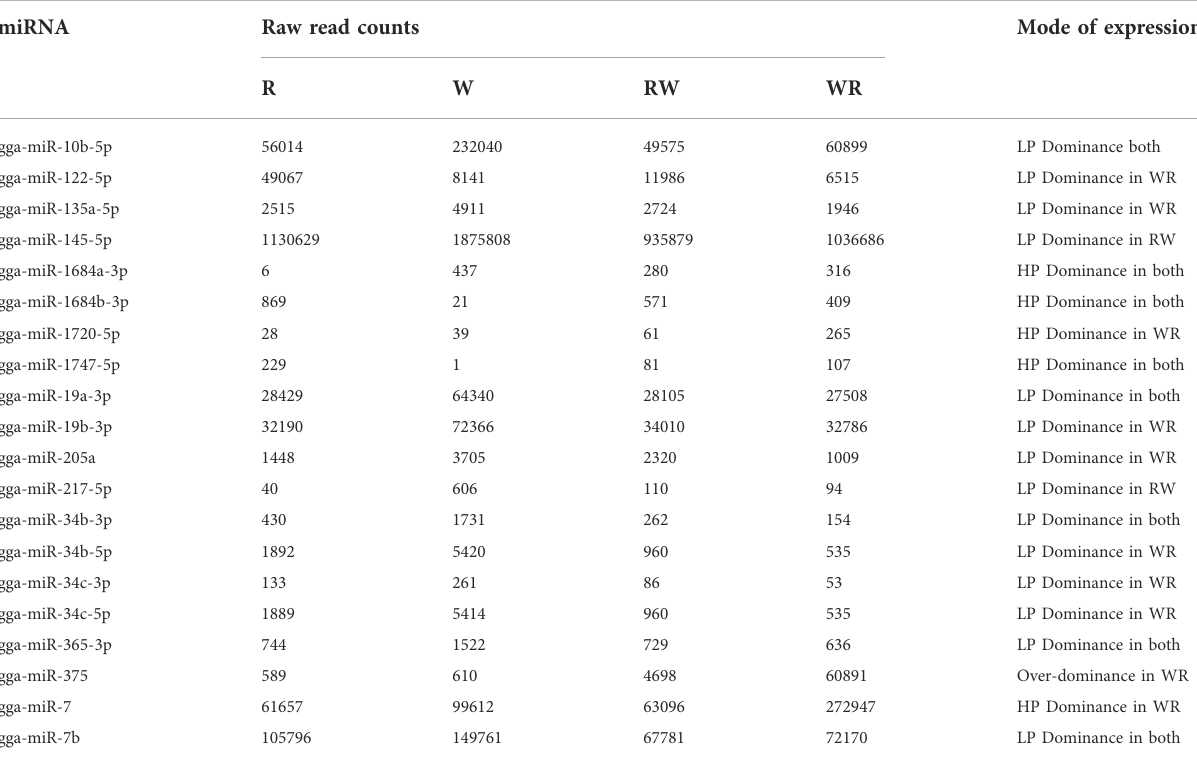
TABLE2KnownmiRNAs abundanceandtheirnon-additivemodesofexpressionintheovary ofpurebredWhiteLeghorn,RhodeIslandRed,andtheir reciprocal hybrids.